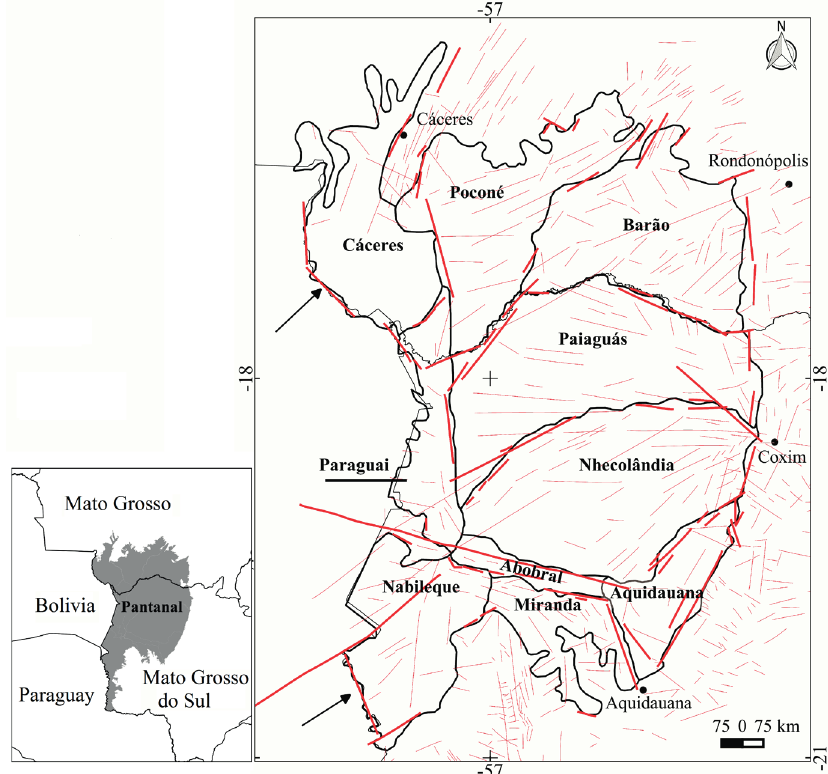
Figure 5 - Structural lineaments (in red) that coincide with the limits proposed by Adámoli (1982) (in black). the arrows to the left indicate places where the external boundaries formed by the Paraguay and Cáceres rivers coincide with the lineaments. the Adámoli sub-regions, the Pantanal, Paiaguás, Nhecolândia, Aquidauana and Abobral boundaries are almost entirely concordant with the